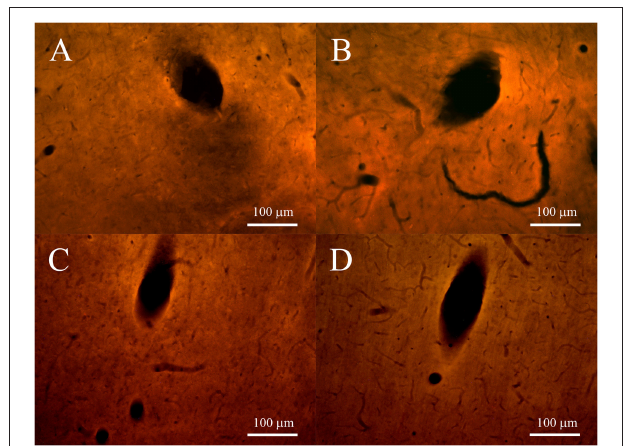
FIGURE 11 | Fluorescence microscopy images of tracks for non-encapsulated (left panels) and pHEMA-encapsulated (right panels) microspheres, 2 and 4 weeks after the implant. (A,B) show the ED1-positive cells (red) at 20 × at 2 weeks; (C,D) show the ED1-positive cells (red) at 20 × at 4 weeks.